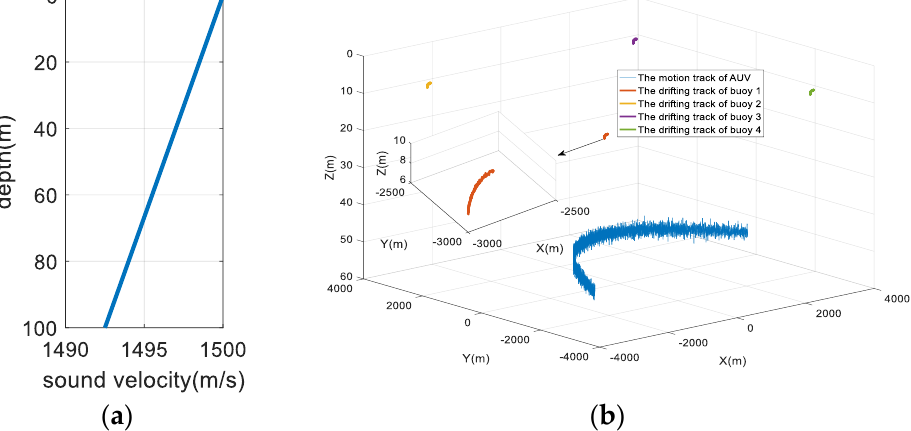
Figure 5. Simulation conditions. ( a ) The simulated sound velocity profile; ( b ) the floating trajectory of the buoy and the motion trajectory of the underwater mobile node. Figure 6 is the result of the modem position of buoy 1. The blue line with * is the GPS direct measurement result, the red line with o is the real position of the modem of buoy 1, and the yellow belt + line corresponds to the result after the space position calibration of Section 3.1 is performed. It can be seen from Figure 6 that the position of the modem obtained after the spatial position calibration is close to the true position while the GPS direct measurement result has a large deviation from the real position of the